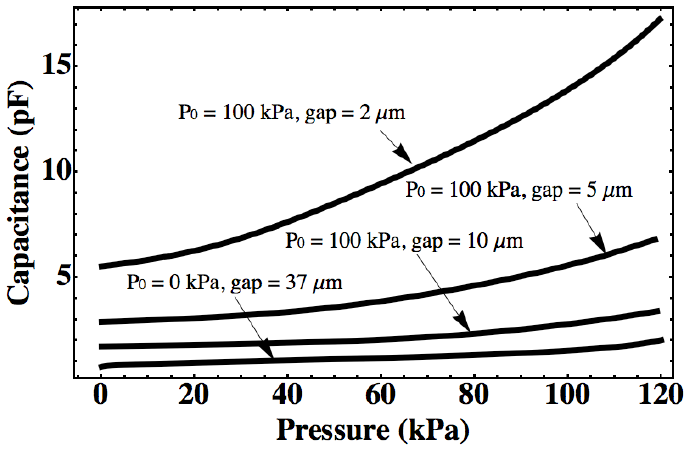
Figure 3. The capacitance of cavity calculated by large-deflection model with different cavity gap and initial sealed gas pressure. The radius of the diaphragm is 1 mm, and the thickness is 5 μ m.